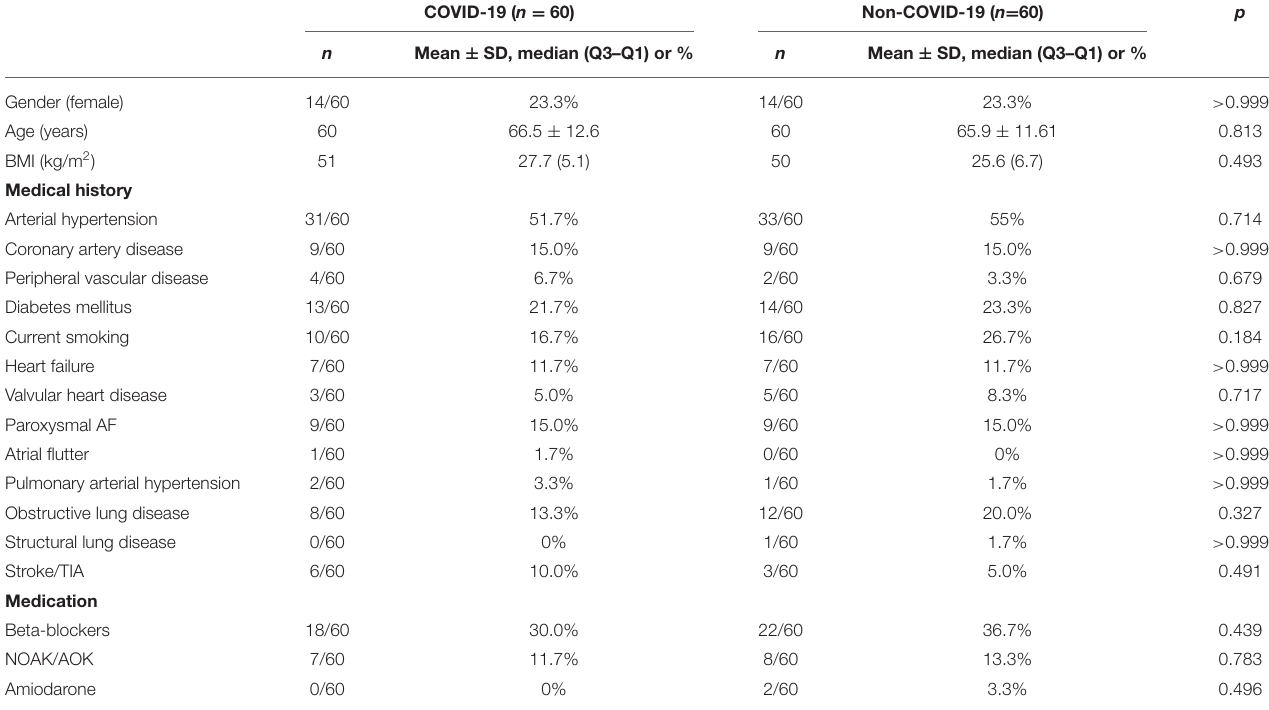
TABLE 1 | Baseline